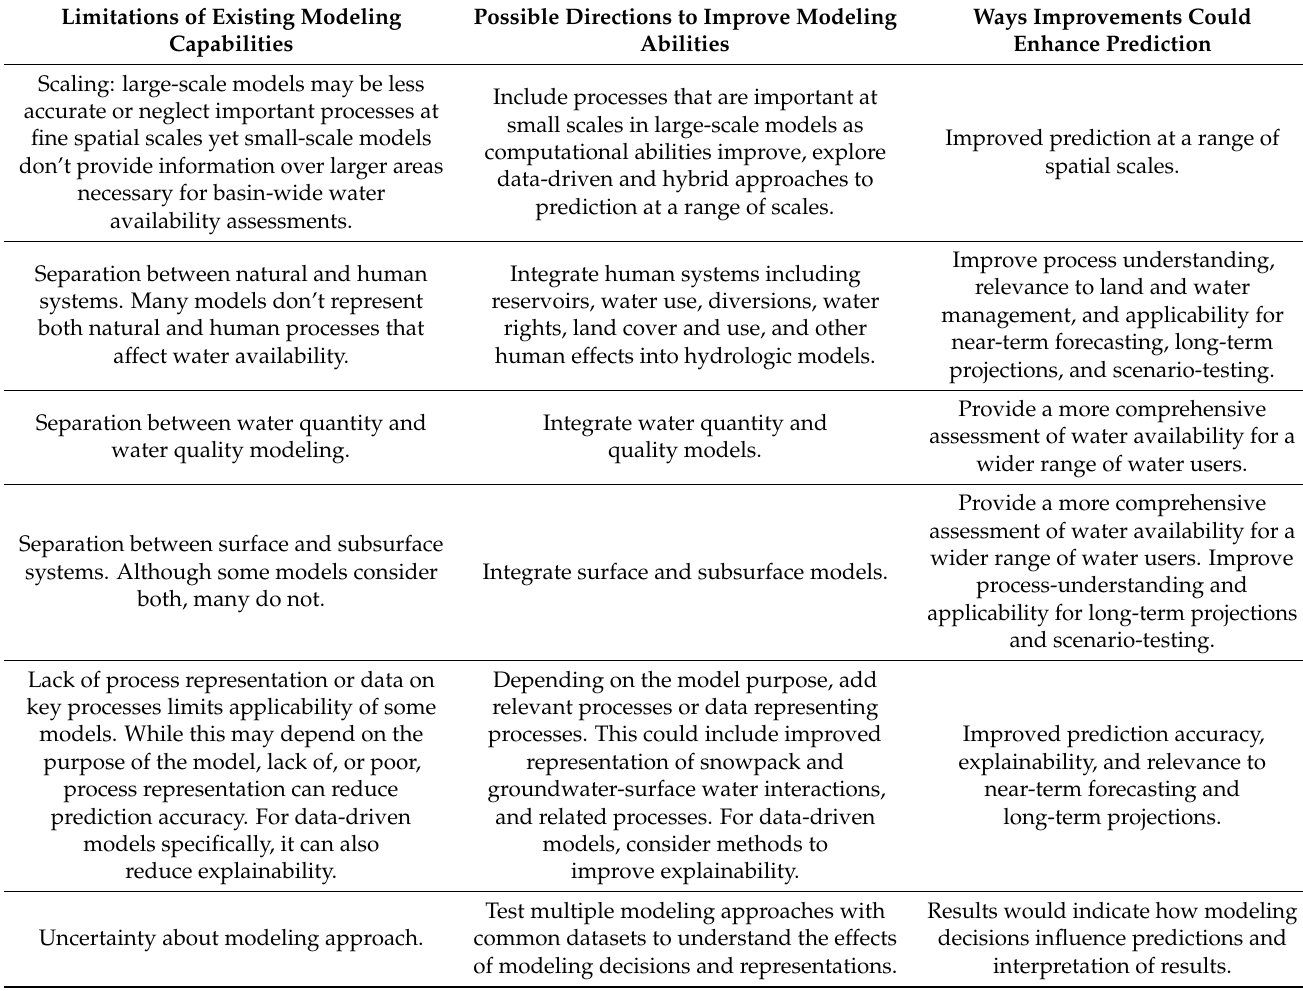
Table 6. Limitations of existing modeling abilities and opportunities for